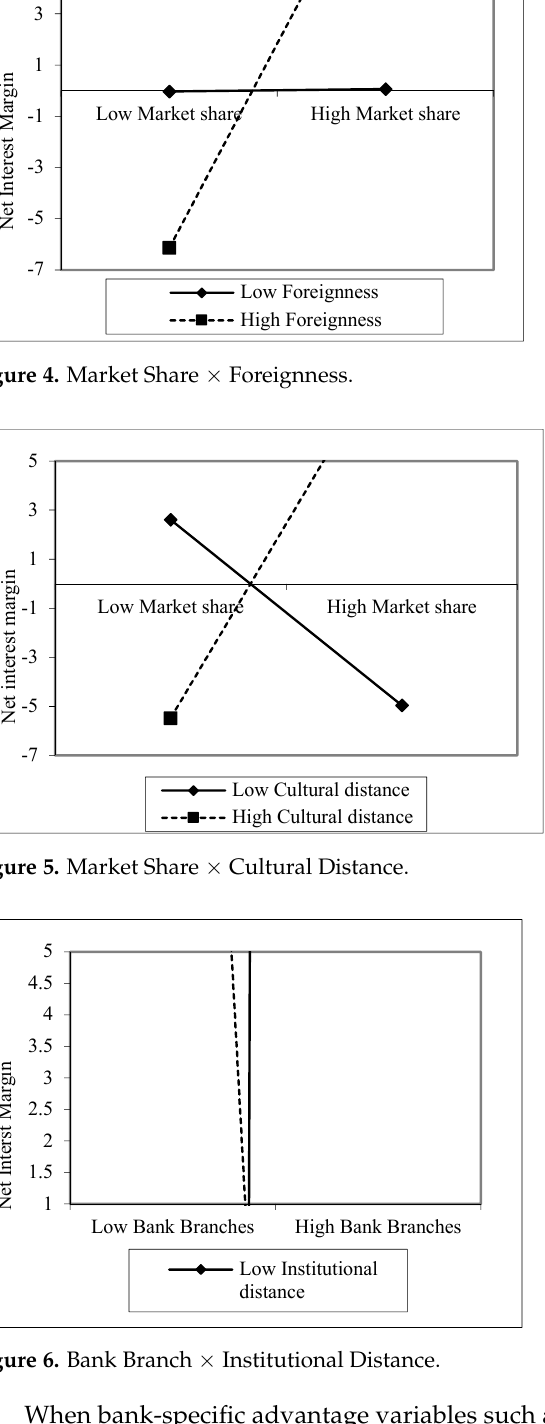
Figure 3. Market Share × Economic Freedom Distance.